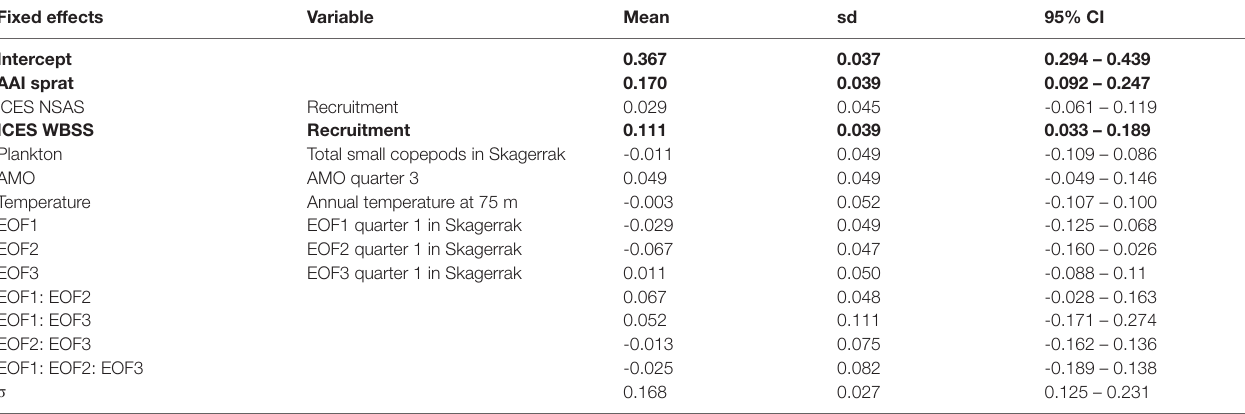
TABLE 2 | Annual abundance index (AAI) of herring final model for the period 1991-2012: parameter estimates (mean, standard deviation (sd) and 95% confidence interval (CI)) for fixed effects and selected variables, and the precision parameter (σ) of the Gaussian distribution. Fixed effects